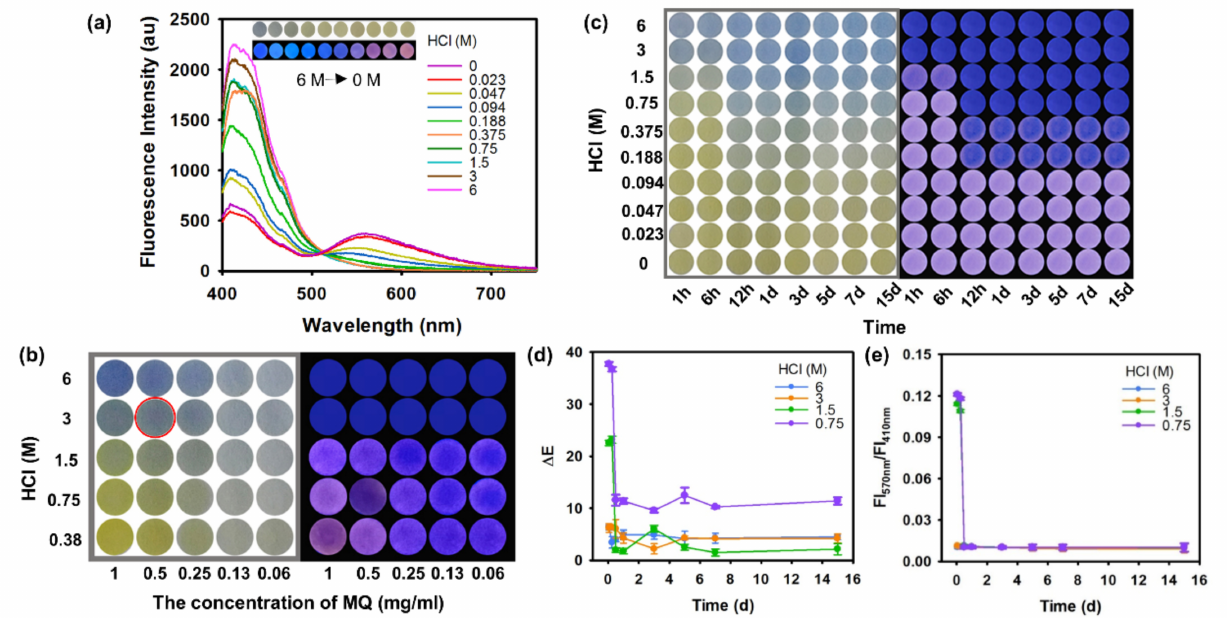
Figure 1. ( a ) Photoluminescence spectra of the H + MQ-loaded paper chip in response to different HCl concentrations. ( b ) Optimization of HCl and MQ deposited on the paper chip. ( c ) Photographs, ( d ) DE, and ( e ) FI 570nm /FI 410nm of the H + MQ-loaded paper chip when treated with 5% glycerinum and 5% sucrose during